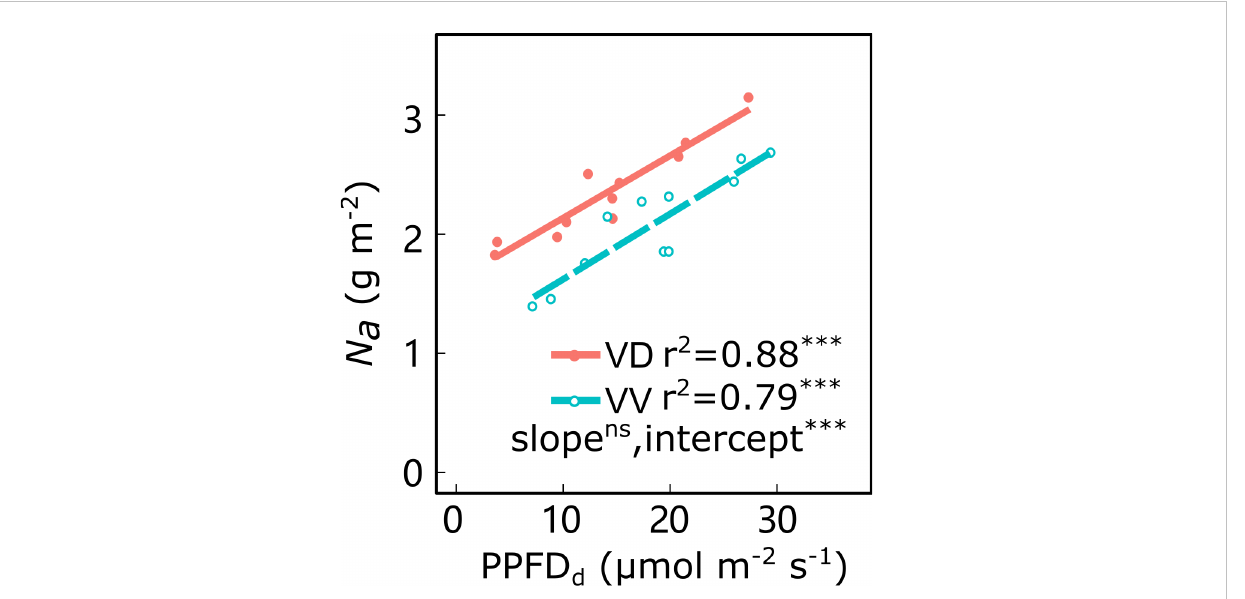
FIGURE 4 Relationships between daily cumulated photosynthetic photon fl ux density (PPFD d ) and leaf nitrogen content per area ( N a ) for ‘ Gala ’ apple trees grafted on vigorous rootstocks associated either with a dwarf M26 interstock (VD) or a vigorous ‘ Qinguan ’ interstock (VV). Linear regression coef fi cients (r 2 ) and signi fi cance and interstock effect on slope and intercept are shown when P < 0.001 with *** and no signi fi cant difference with